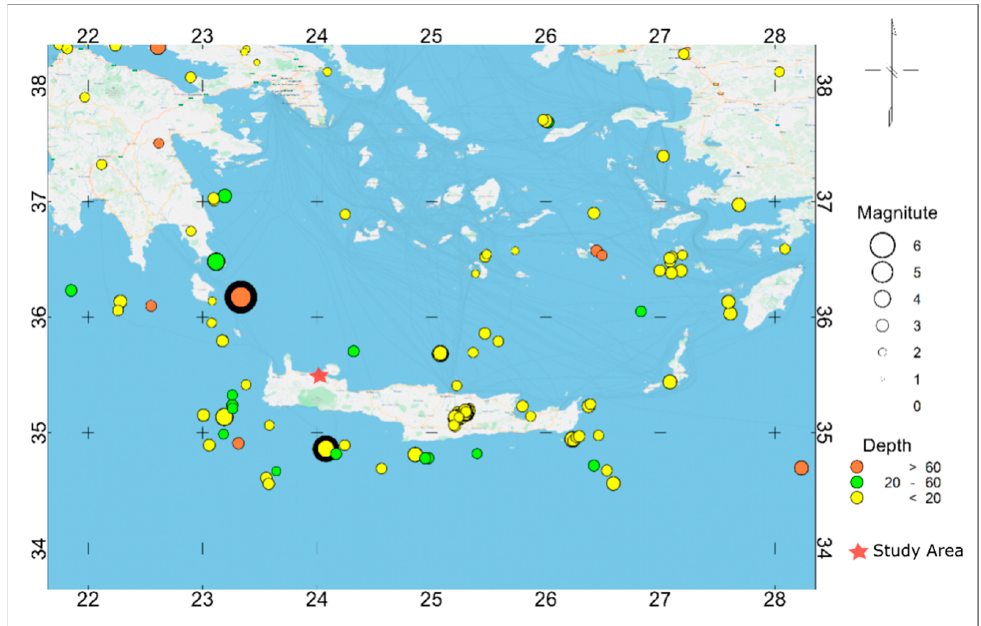
Figure 2. Spatial distribution of the shallow seismicity for M w >1 in the broader area of the island of Crete for the period of 01/11/2021–18/11/2021 (18 days), as derived from the A.U.Th. Seismological Network (http://geophysics.geo.auth.gr/ss/, accessed on 19 November 2021). The locations of the Kythira (NW of Chania) and Gavdos (SSE of Chania) earthquakes are also shown (orange and yellow circles, respectively, with thick black borders).